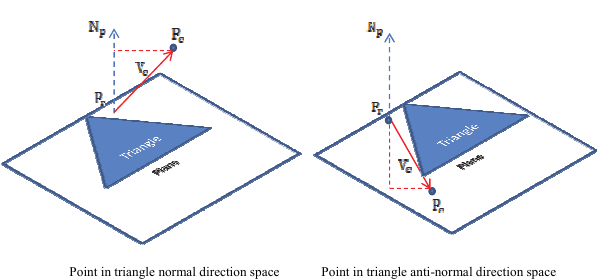
Figure 4. Typical spatial relationships with communication unit and the building